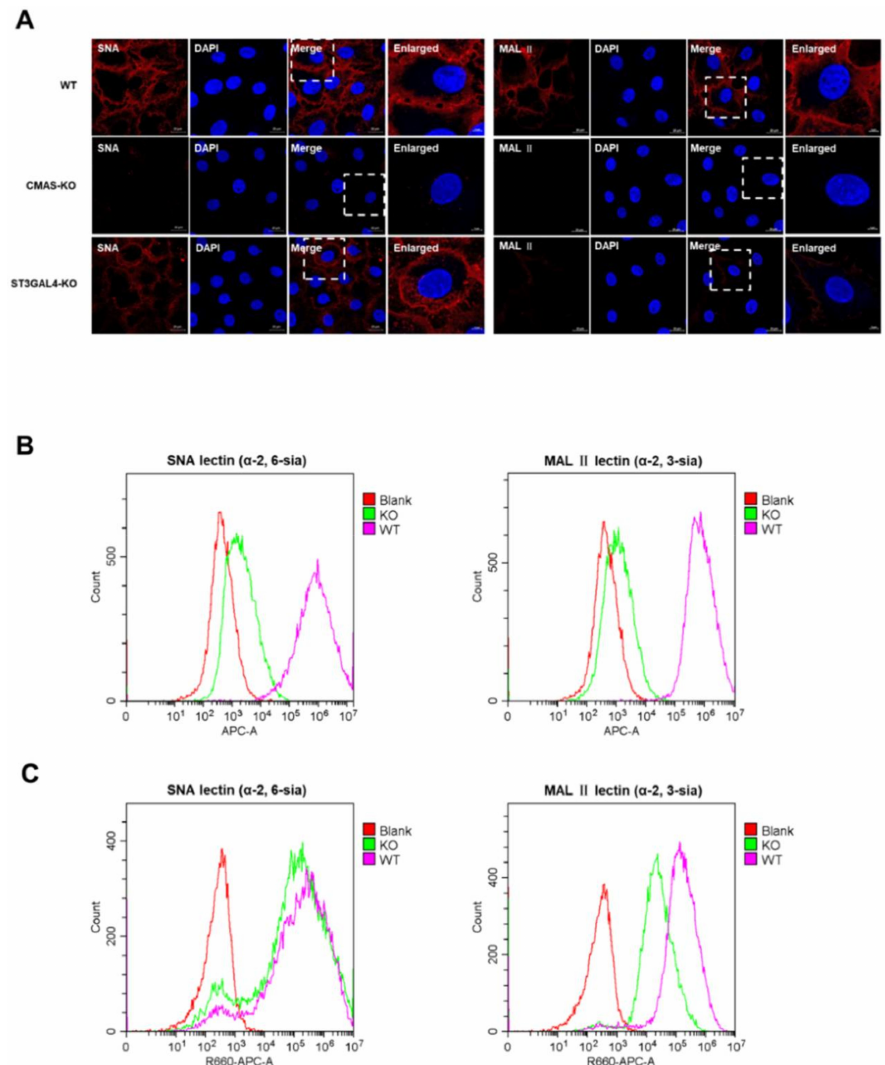
Figure 5. The effect of CMAS and ST3GAL4 on the synthesis of different types of sialic acid receptors. CMAS-KO and ST3GAL4-KO NPTr cells were generated through the CRISPR/Cas9 system; NPTR- Cas9 cells were used as wild-type control. (A–C) The expression of sialic acid was analyzed by lectin staining. WT NPTr cells and KO NPTr cells were treated with lectins specific for α -2,6-linked sialic acid (SNA) or α -2,3-linked sialic acid (MAL). (A) Fluorescent microscopy analysis of the effect of CMAS or ST3GAL4 knockout on the synthesis of sialic acid receptors. (B) Flow cytometry analysis of the effect of CMAS knockout on the synthesis of sialic acid receptors. (C) Flow cytometry analysis of the effect of ST3GAL4 knockout on the synthesis of sialic acid receptors. Blank cells were stained with only Cy5-streptavidin, but not treated with lectin. Scale bar = 20 µ m or 5 µ